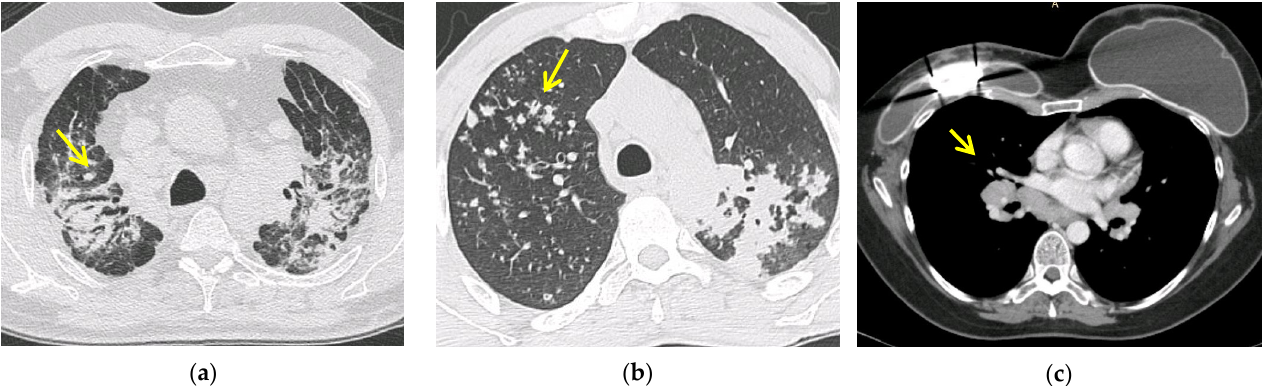
Figure 2. Pulmonary silicosis with predominantly upper lobes fibrosis and traction bronchiectasis (yellow narrow) ( a ); conglomerate masses and pulmonary micronodules (yellow narrow) in patient with tuberculosis ( b ); enlarged bilateral hilar lymph nodes (yellow narrow), a sarcoid-like-reaction in patient with mammal carcinoma ( c ).